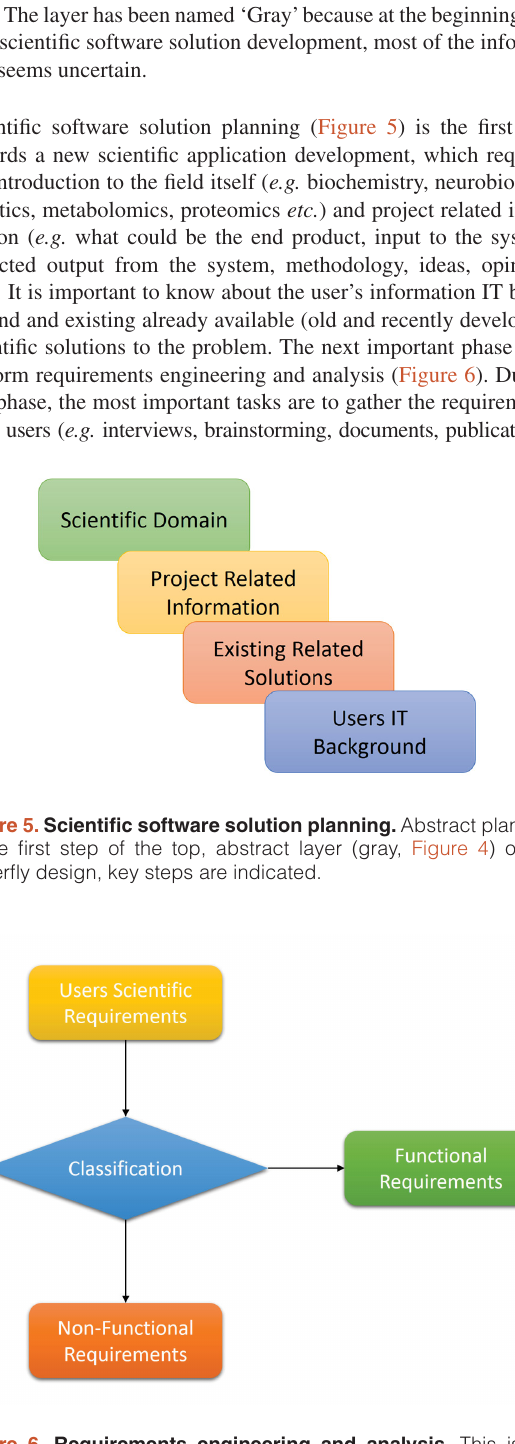
Figure 8. User Friendly Graphical Interface Designing. This is the final step of the top, abstract layer (gray) of the three layers in the butterfly design.